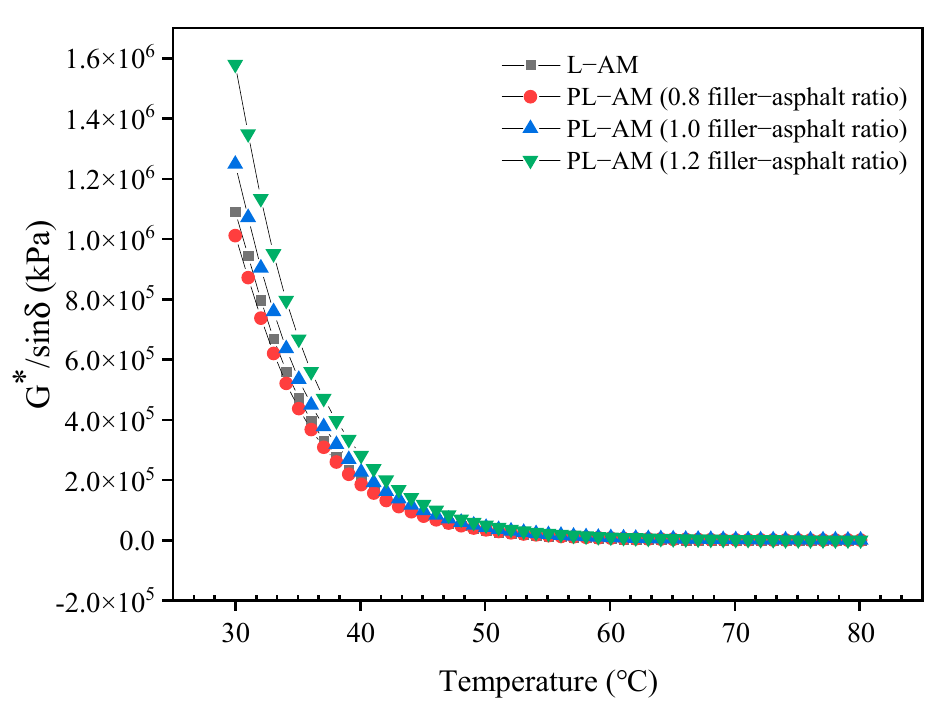
Figure 12. G* and δ of PL-AM and L-AM.